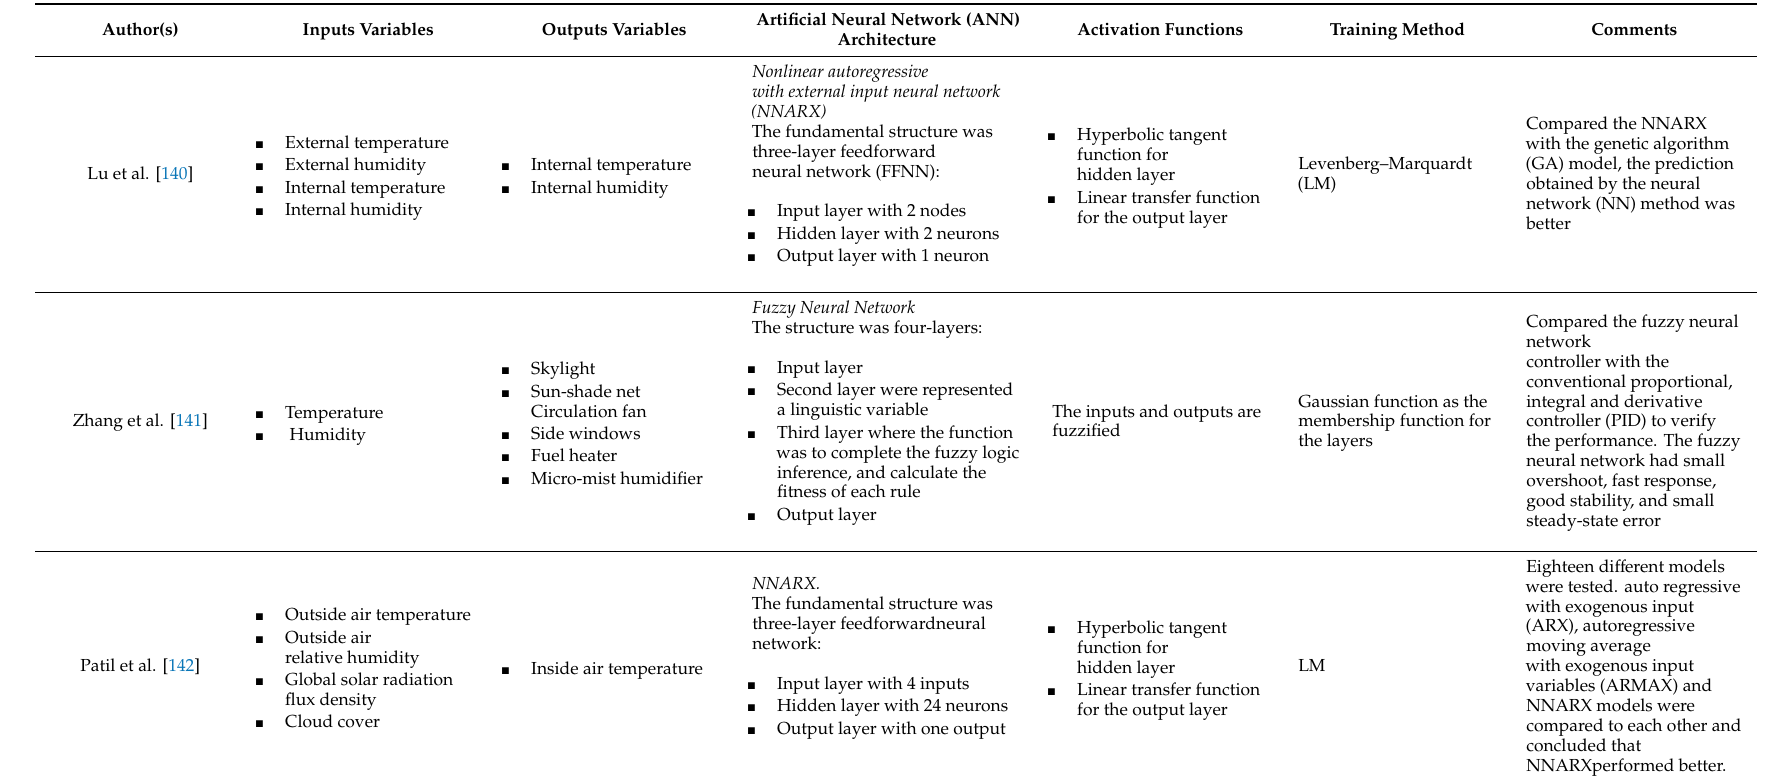
Table 4. Other types of neural network models for prediction of microclimate in